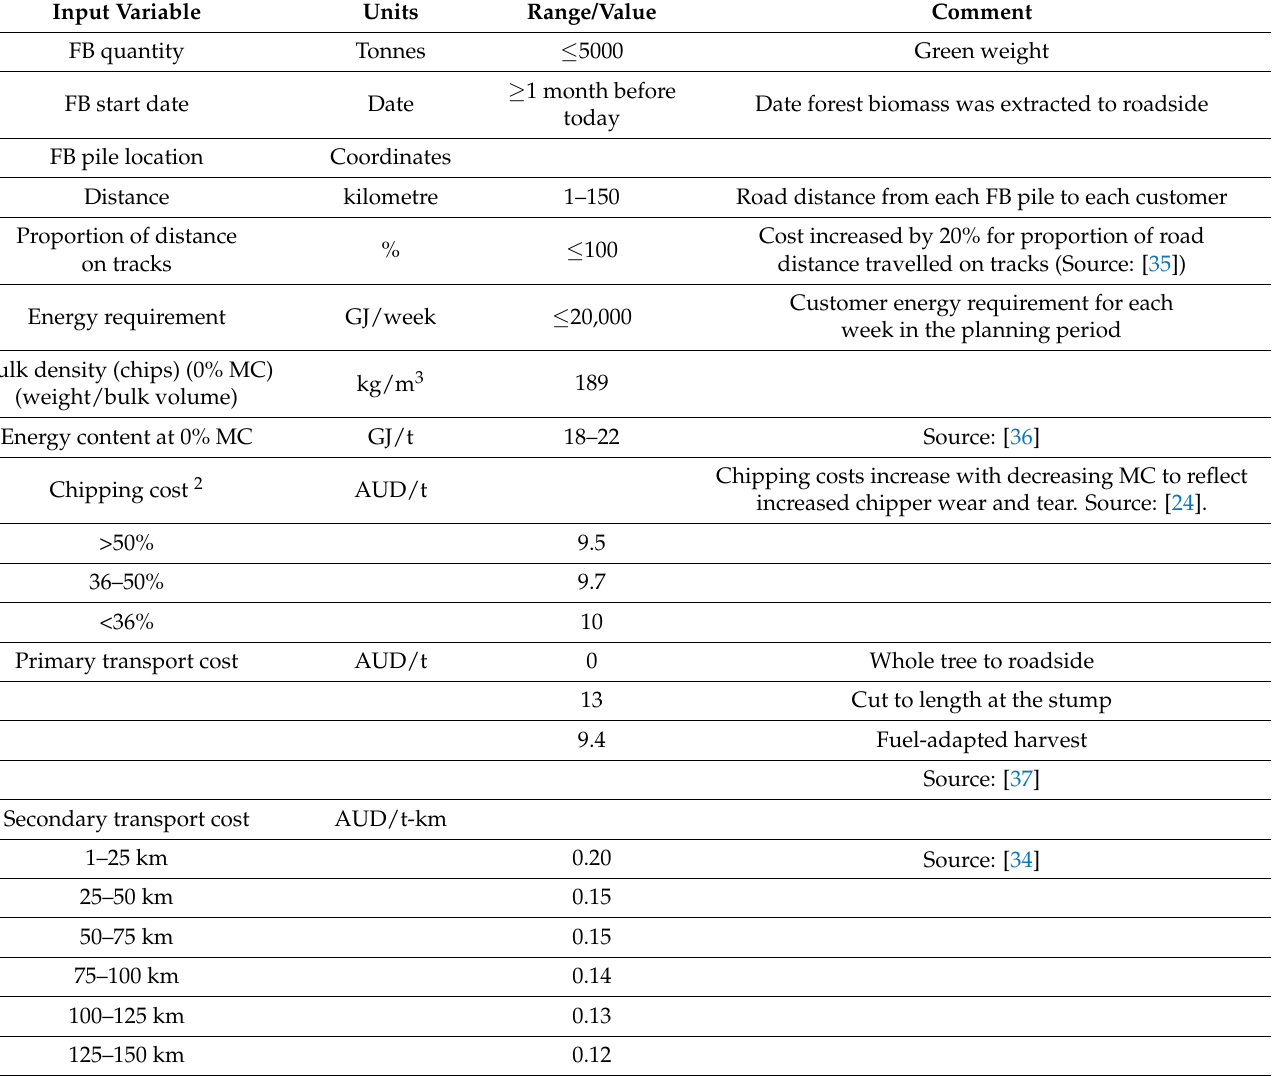
Table 1. Operational DSS input variables 1